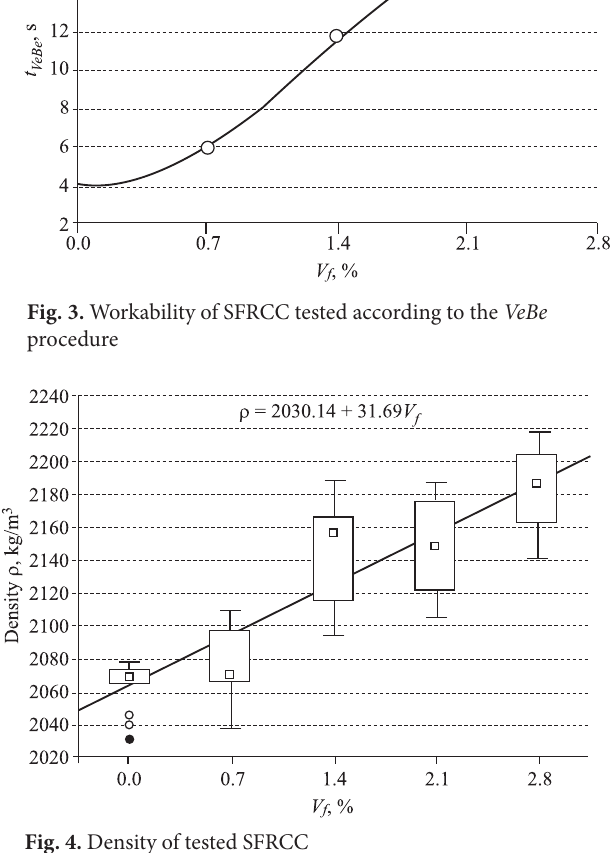
Fig. 4. Density of tested SFRCC